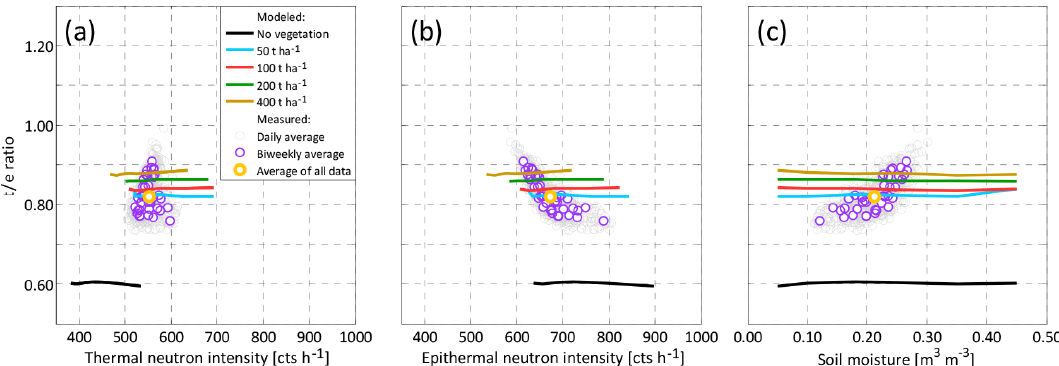
Figure 9. Neutron intensities measured at Gludsted plantation in the time period 2013–2015 and modeled using the model foliage. Ground-level thermal-to-epithermal neutron intensity ratio plotted against measured and modeled (a) ground-level thermal neutron intensity, (b) ground-level epithermal neutron intensity and (c) volumetric soil moisture.